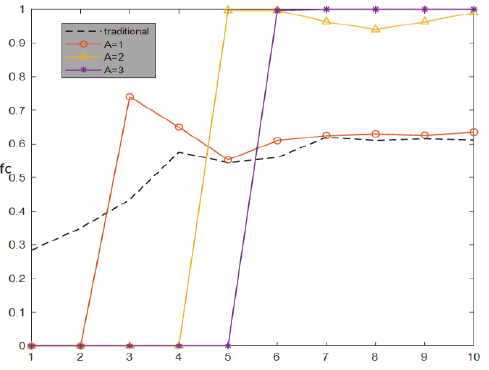
Figure 5. Evolution of the cooperation rate f c with the gain factor r for different values of the desired intensity A .